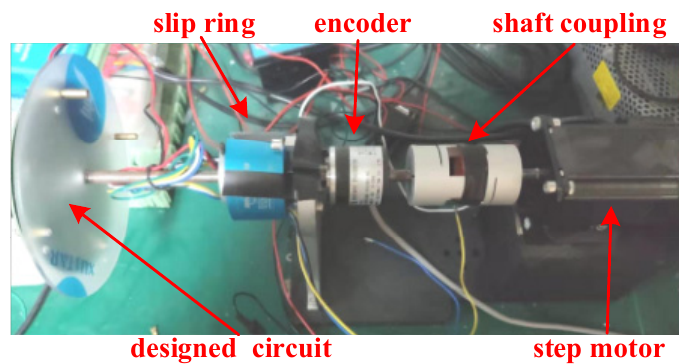
Figure 15. The designed test stand.